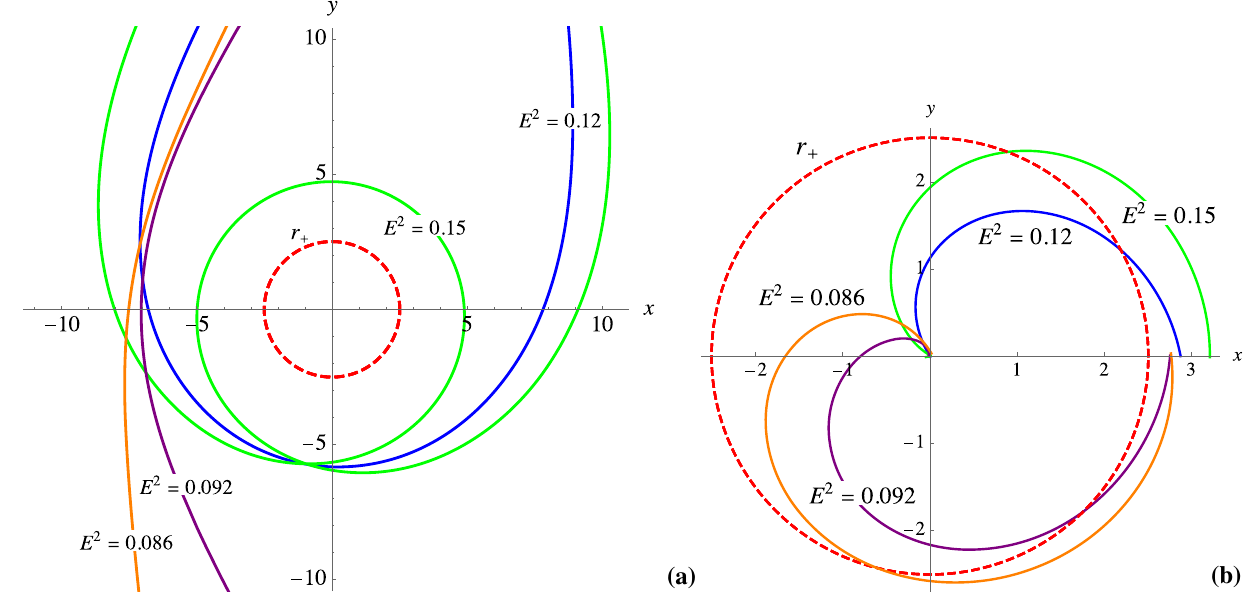
Fig. 7 The deflecting trajectories for null geodesics corresponding to a OFK, and b OSK, plotted for different values of E 2 and in accordance with the parameters given in Fig.